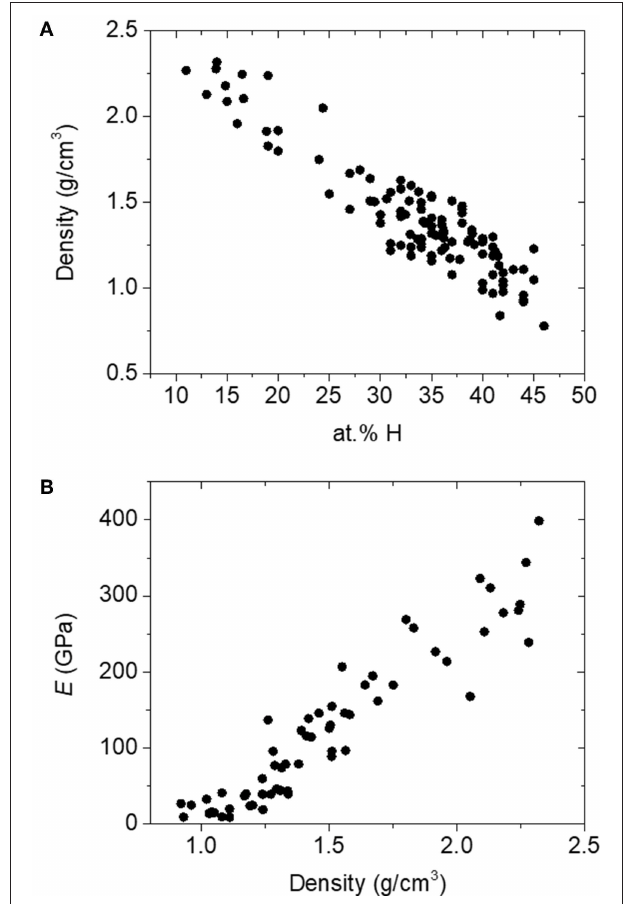
FIGURE 2 | (A) Range of density and atomic concentration hydrogen in amorphous hydrogenated boron carbide films. (B) Young’s modulus ( E ) as a function of density in a-BC:H